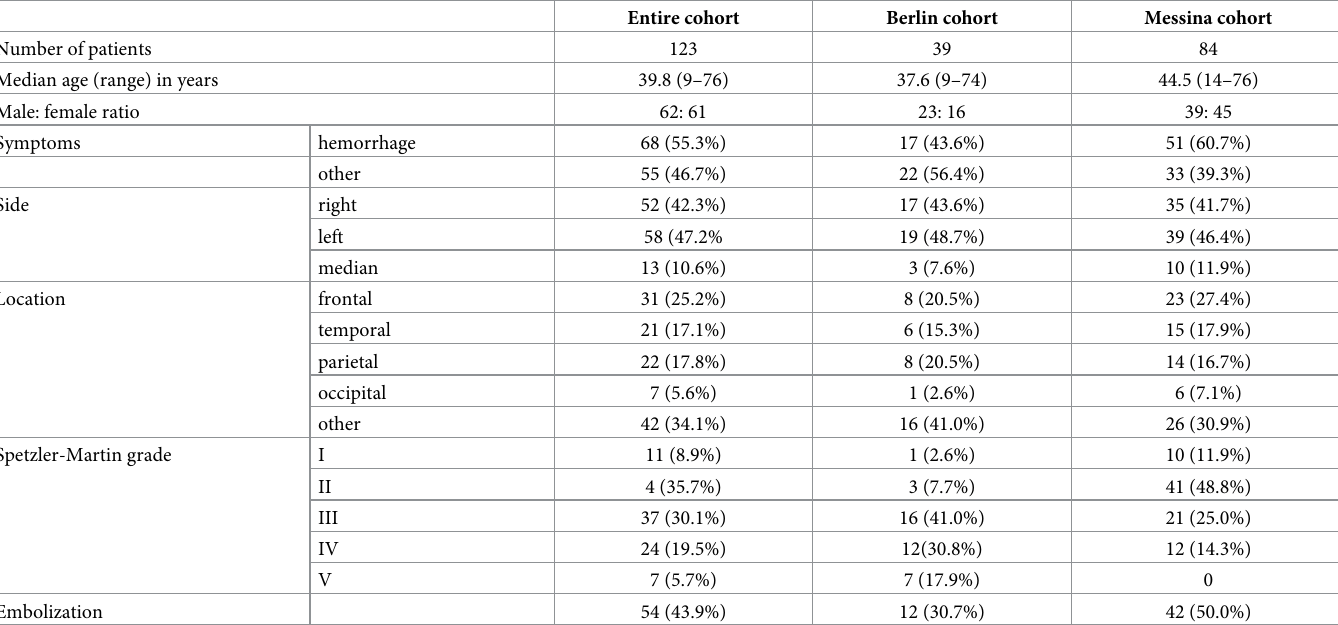
Table 1. Clinical characteristics of the patient cohort and